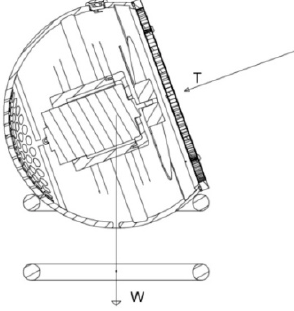
Figure 13. Forces acting on the central body and stress analysis.